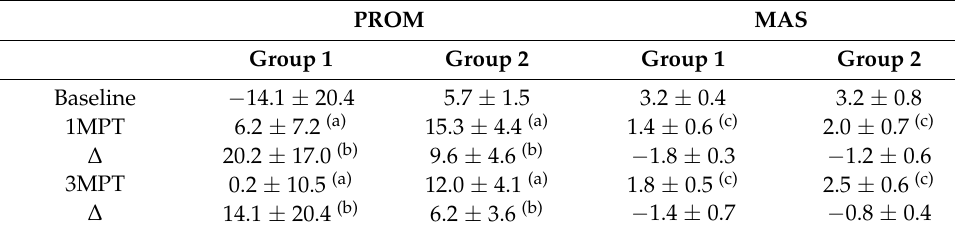
Table 1. Comparison of changes in range of motion and modified Ashworth scale post injection between group 1 and 2.